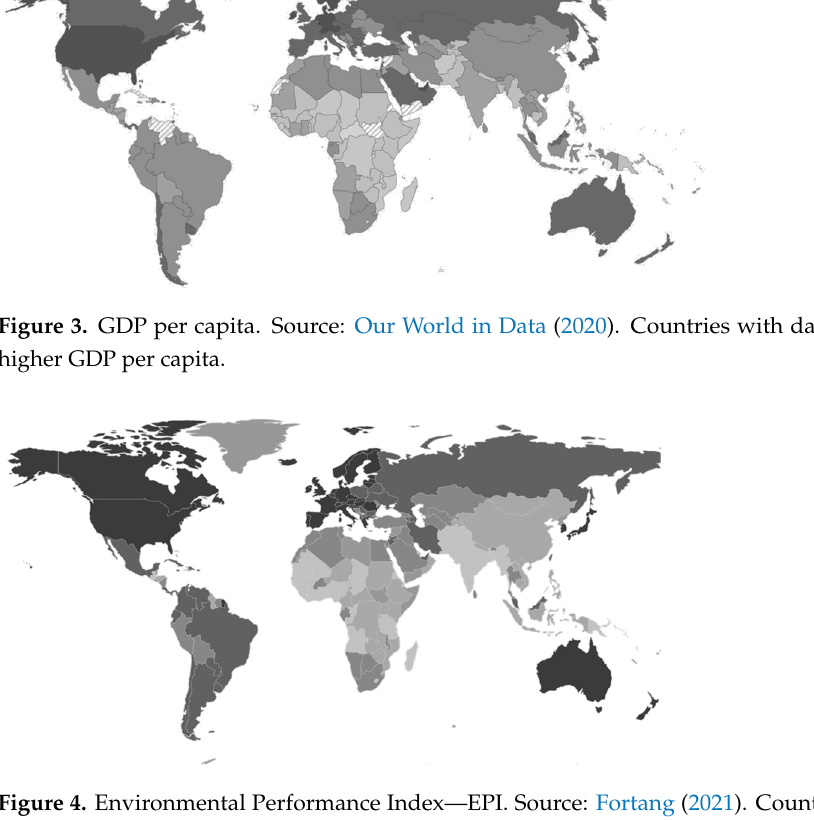
Figure 5. Overall score on total progress toward achieving the SDGs. Source: Sachs et al. (2022). Countries with darker colors have a higher degree of achievement of the SDGs. Next, a group discussion on international inequalities will be initiated around the following questions: a.